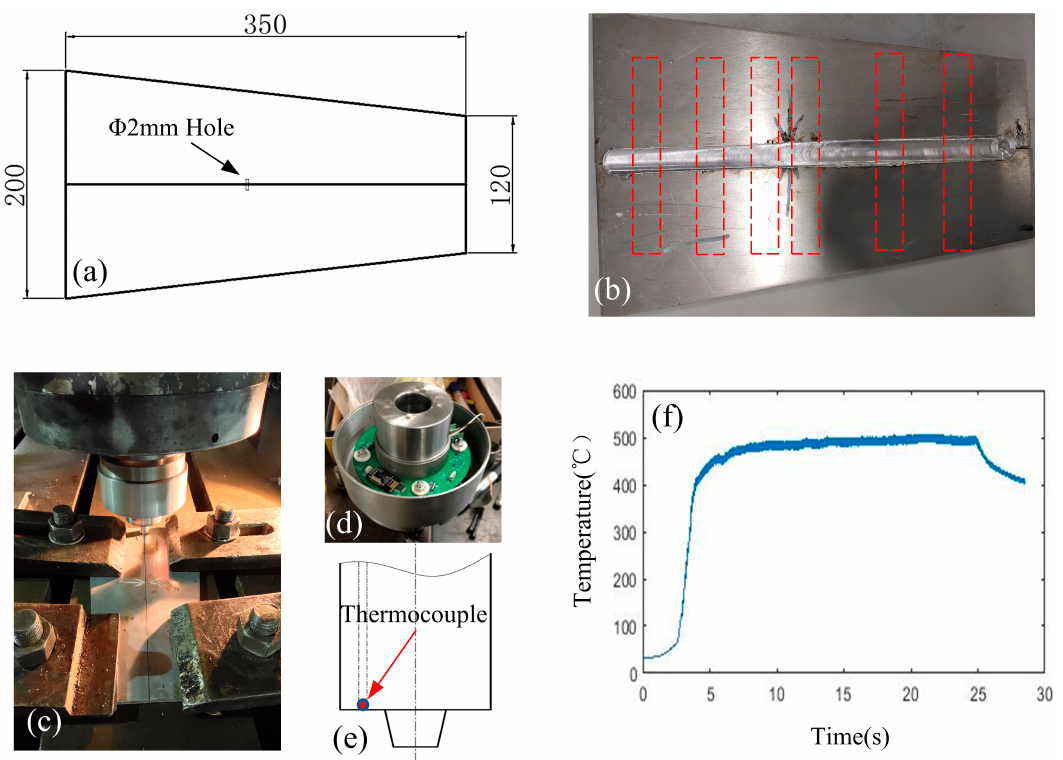
Figure 1. Welding experiment process: ( a ) The main dimensions of the workpiece; ( b ) Welding specimen; ( c ) Temperature signal processing module; ( d ) Friction stir welding experiment; ( e ) Position of temperature measuring point of thermocouple embedded tool; and ( f ): Temperature signal during welding.